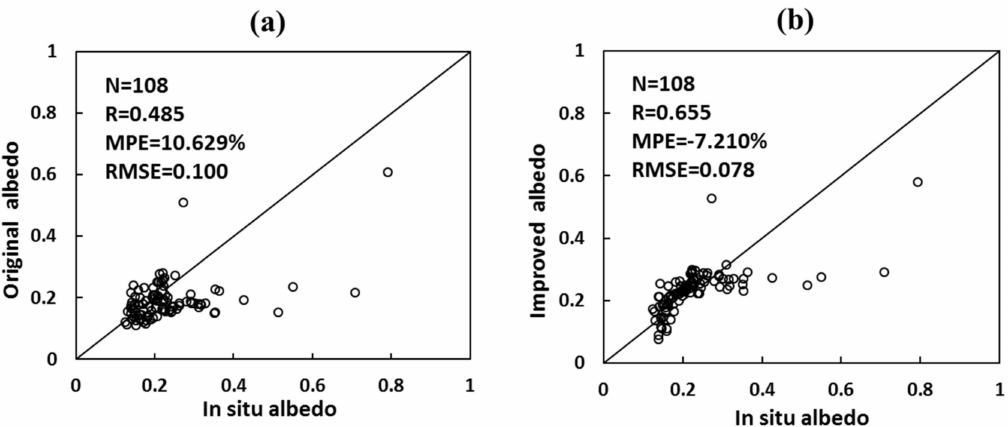
Figure 3. Comparisons of the original model ( a ) and improved model ( b ) results with in situ measurements at four stations of NPAM, BJ, D105, and